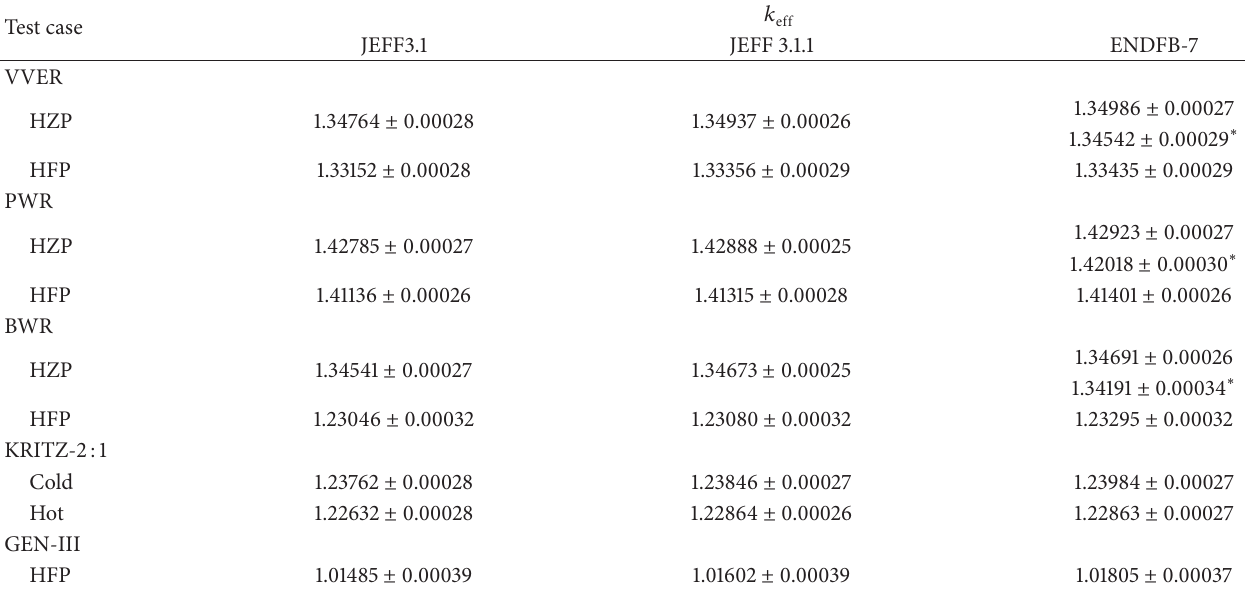
Table 7: Phase I-1 Exercise: